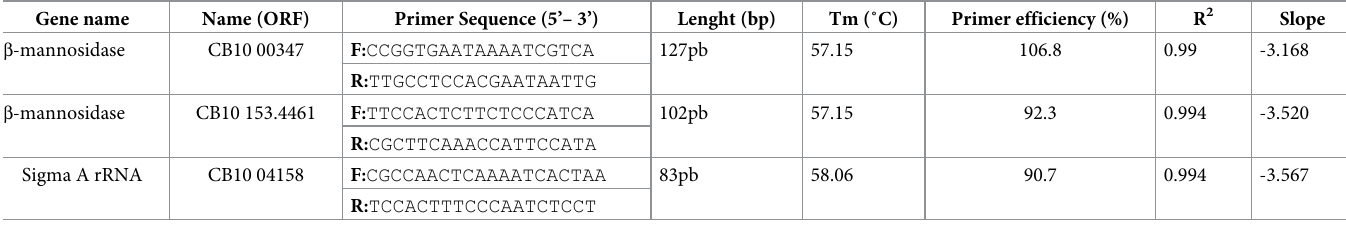
Table 1. Characteristics of the primers used in the analysis of